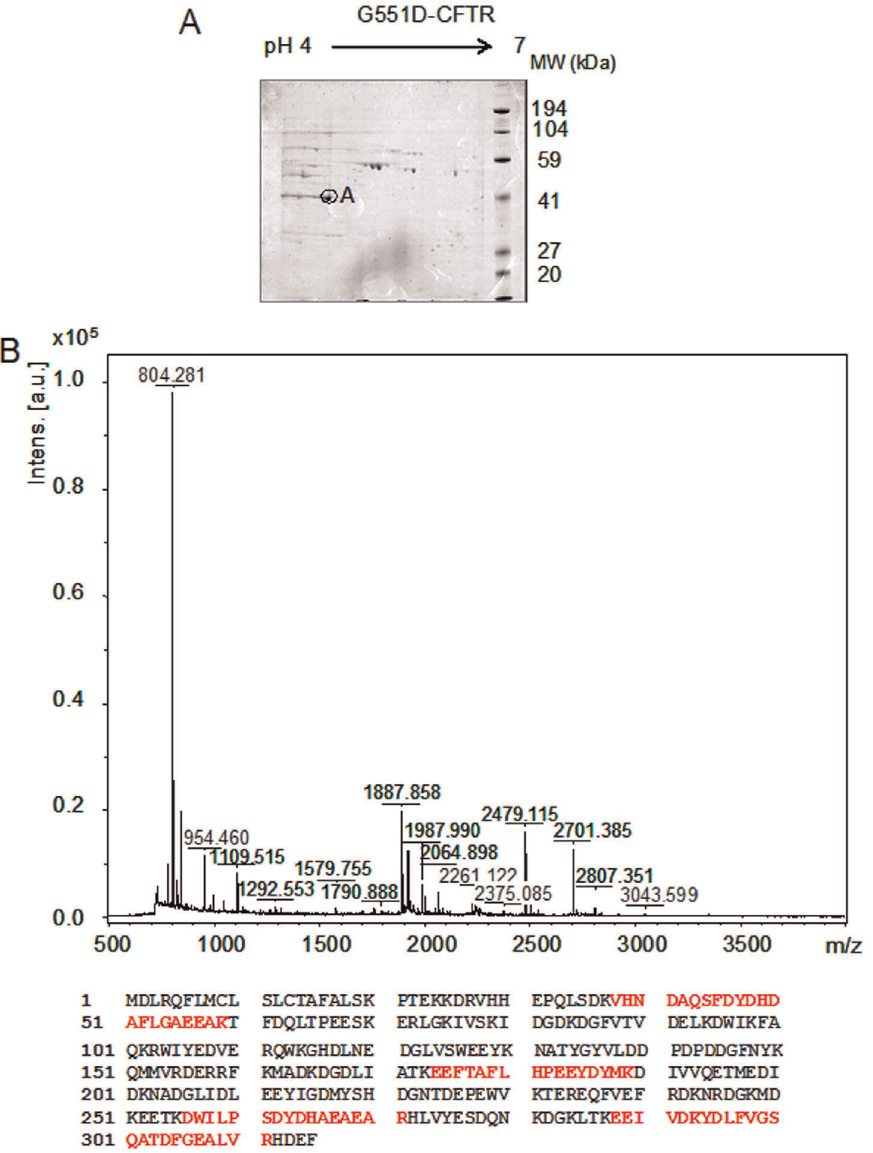
Figure 2. Calumenin belongs to the G551D-CFTR’s complex. A, Example of a reference 2-DE (pH 4–7) of 6 gels performed with immunoprecipitated G551D-CFTR. The image analysis detected 165 protein spots. The analyzed spot is noted as A. B, MS spectra obtained for the A spot and protein coverage (24%) shown in bold red on the calumenin amino acid sequence (gi/2809324).